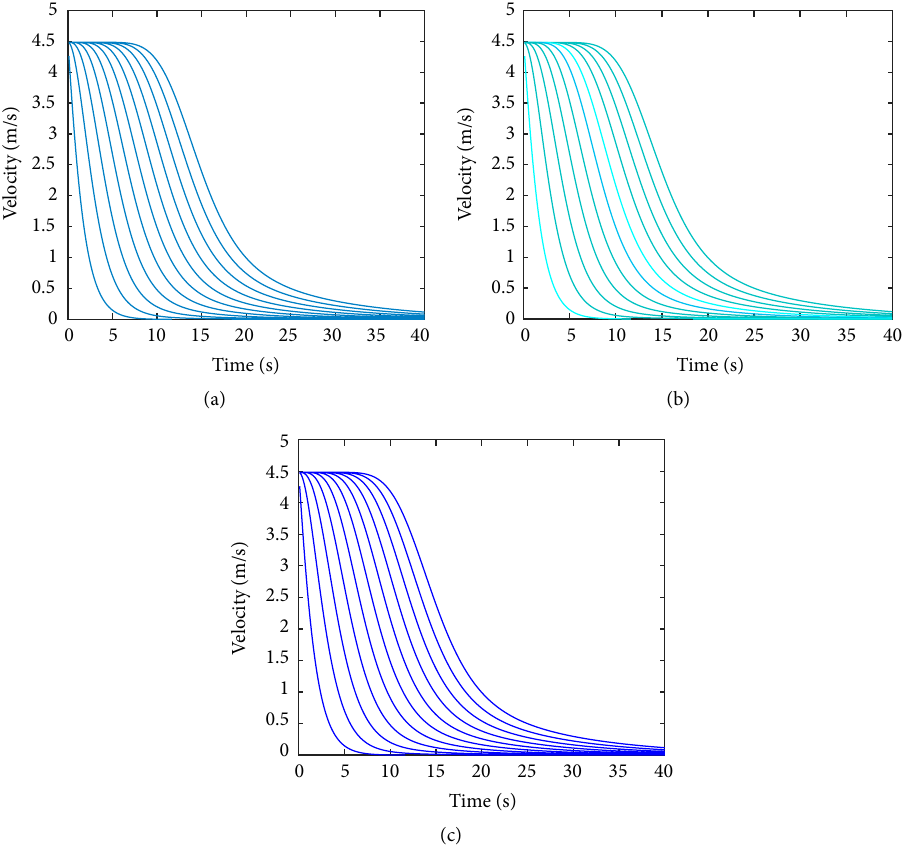
Figure 9: Motions of 11 vehicles during the braking process according to the FVD, AD, and AMD models. (a) FVD model, (b) AD model, and (c) AMD